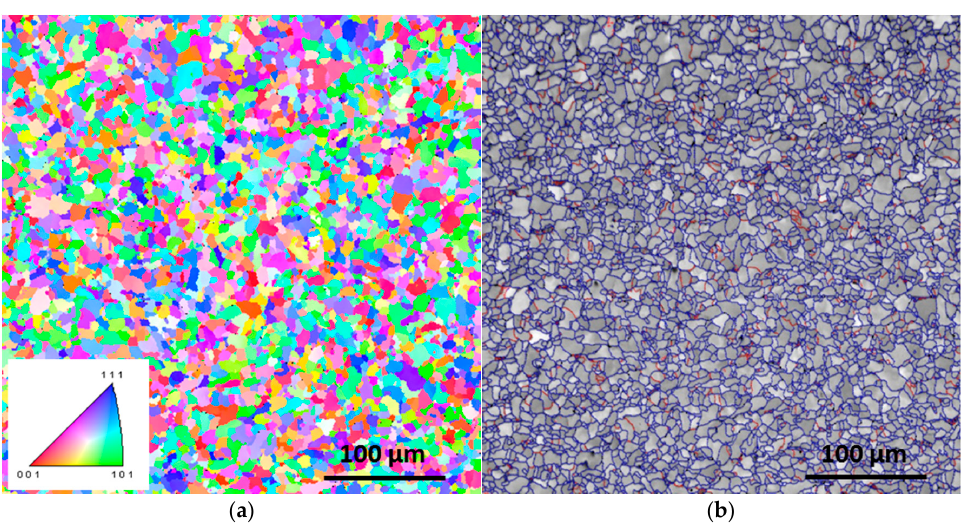
Figure 2. Electron back-scatter diffraction (EBSD) scan: ( a ) Qualitative view of the texture (001 inverse pole figure (IPF) map); ( b ) grain boundary orientations.